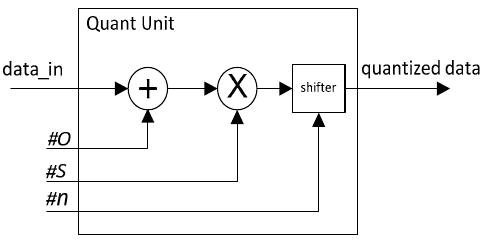
8 of 18 Figure 1. Integer quantization CNN accelerator architecture diagram.